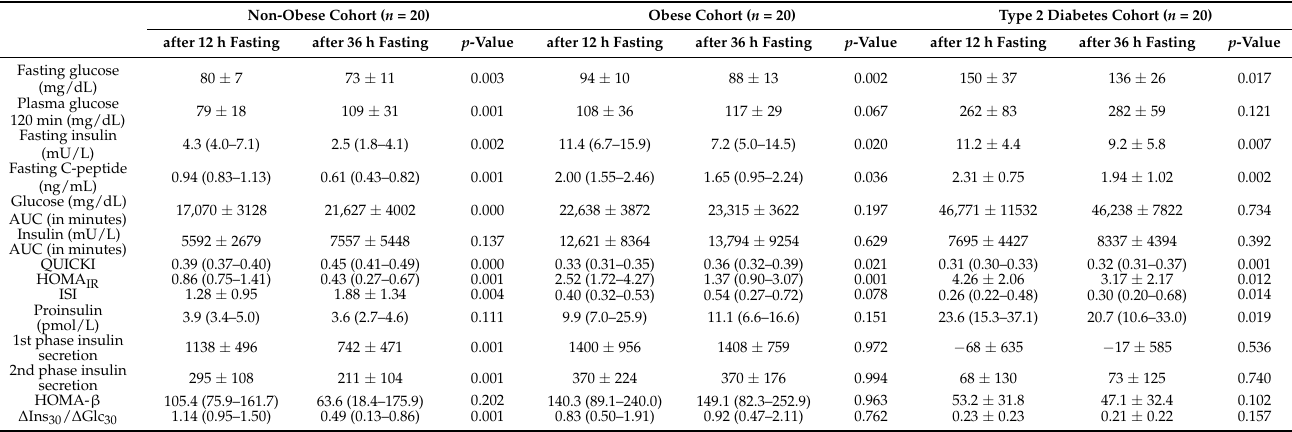
Table 2. Effects of 12 h and 36 h fasting on parameters of glucose